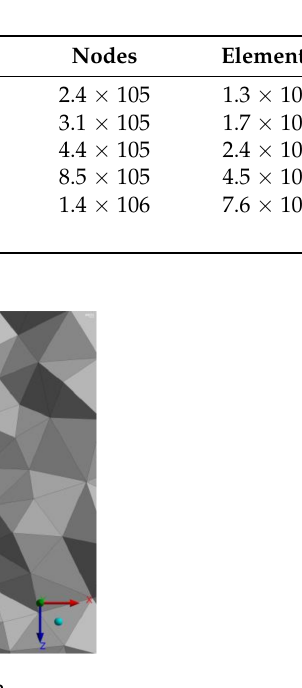
Figure 6. The meshing of an otter board in numerical simulation.